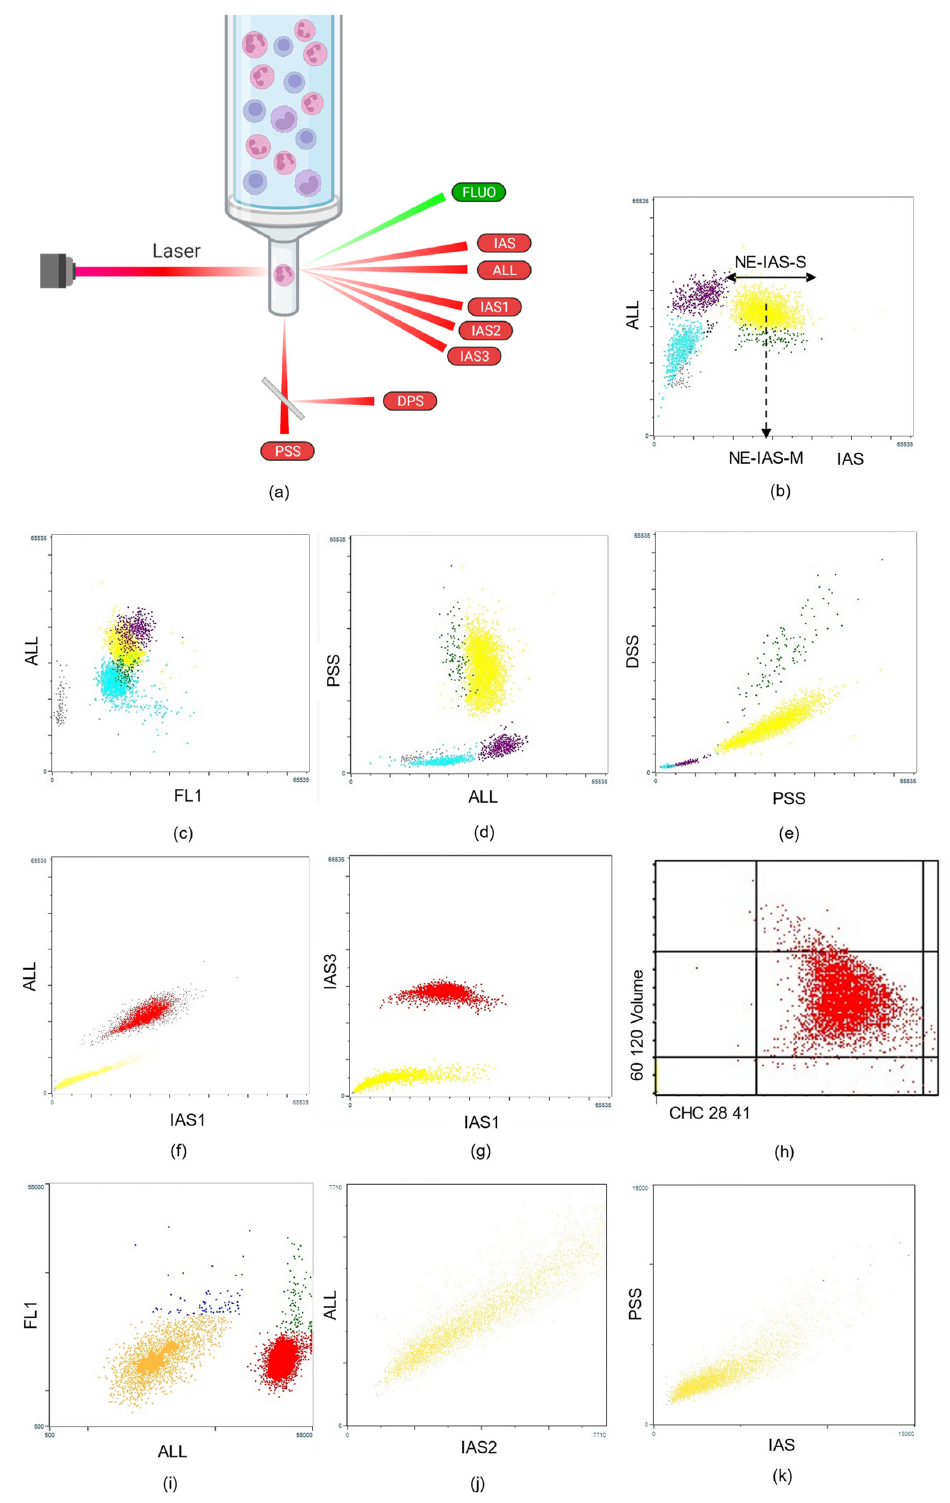
Figure 3. Illustration of the Abbot technology. ( a ) Alinity-hq from Abbott uses seven light scatter detectors to determine various cellular features: axial light loss (ALL) related to size, intermediate-angle scatter (IAS) related to cellular complexity, polarized side scatter (PSS) related to nuclear lobularity/segmentation and depolarized side scatter (DSS) allowing for specific identification of eosinophil granulocytes. The three narrow-angle light scatter detectors IAS1, IAS2 and IAS3 provide